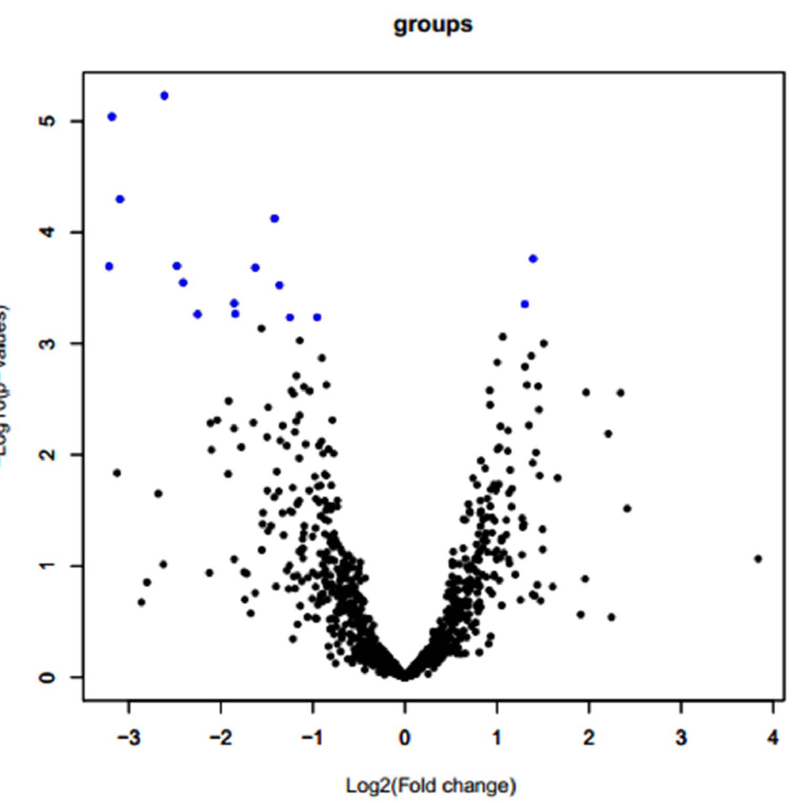
Figure 1. Volcano plots depicting estimated fold changes (log2, x-axis) and statistically significant differences ( 2 log10, p -value, y- axis). Each point represents a gene, and colors correspond to the ranges of the negative log 10 P and log 2 fold change values. Blue circles: differentially expressed genes. Fold changes . 0 indicate up-regulated genes, whereas fold changes , 0 indicate down-regulated genes. Black circles: no statistically significant expressed genes.